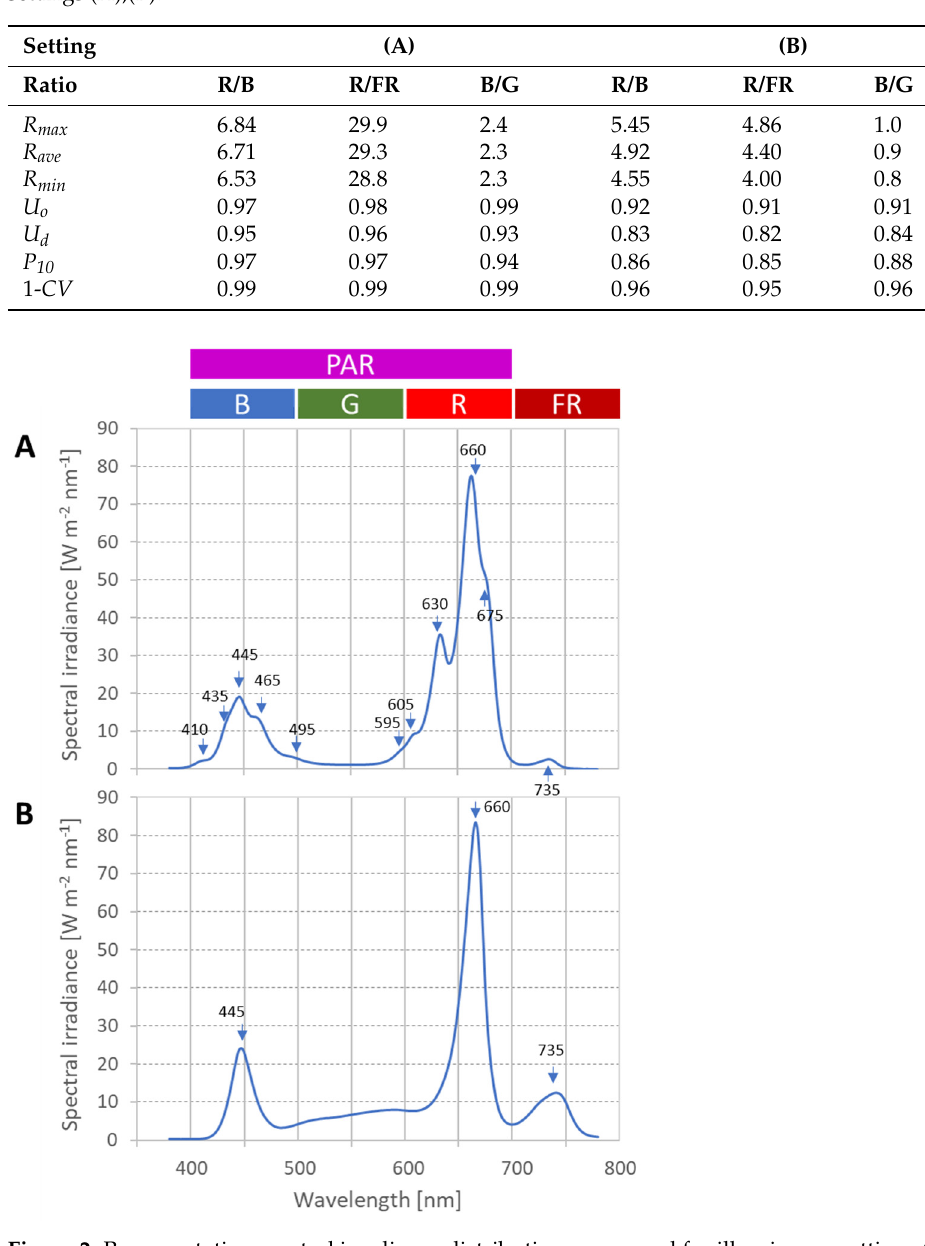
Figure 2. Representative spectral irradiance distributions measured for illuminance settings (A),(B). The numbers adjacent to the arrows indicate the peak wavelength of individual NB LEDs in nanometers. The spectrum is the superposition of 11 types of NB LEDs and one type of white LED in ( A ), whereas 3 types of NB LEDs and one type of white LED in ( B ).Note that the white LEDs have emission peak at 445 nm overlapping with the 445 nm NB LED spectrum. The broad emission between 500 and 600 nm is due to the phosphor emission of white LEDs. In ( B ), the large proportion of white LEDs explain the relatively high spectral intensity between 500–600 nm. The ranges denoted as B, G, R and FR represent wavebands for 400–499 nm, 500–599 nm, 600–699 nm and 700–800 nm, respectively. PAR stands for photosynthetically active radiation covering the wavelength range between 400–700 Table 1. Statistical parameters characterizing the photon irradiance distributions in the B, G, R, FR and PAR wavebands for illuminance settings (A),(B). The photon irradiance parameters (E max, E ave, E min ) have unit μmol m −2 s −1 .